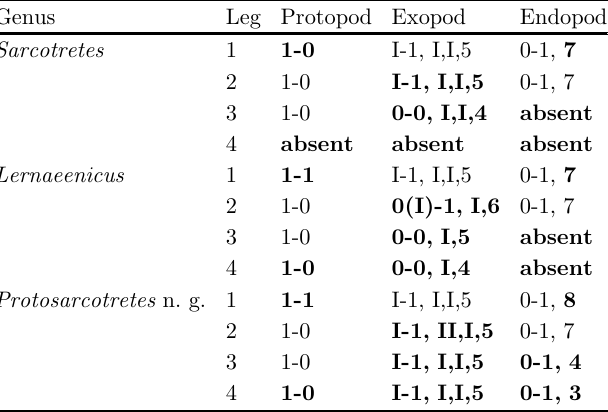
Table 1. Segmentation and setation of legs 1 to 4 of Sarcotretes , Lernaeenicus and Protosarcotretes n. g. Bold letters indicate differences among genera. Number in parentheses shows